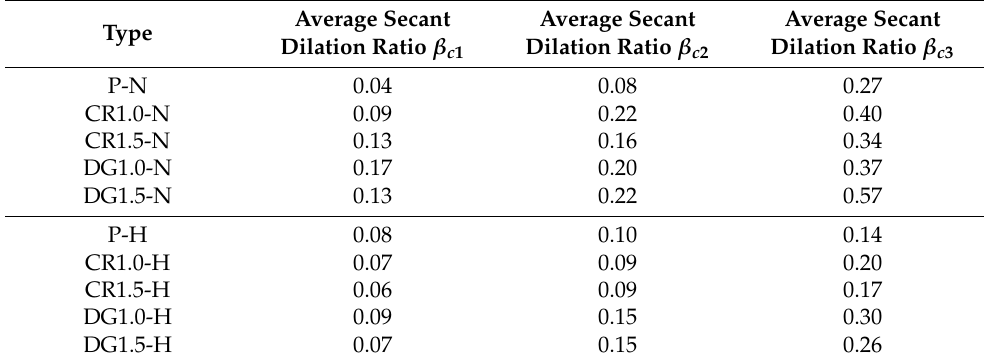
Table 5. Secant dilation ratio after each cycle in the cyclic compressive